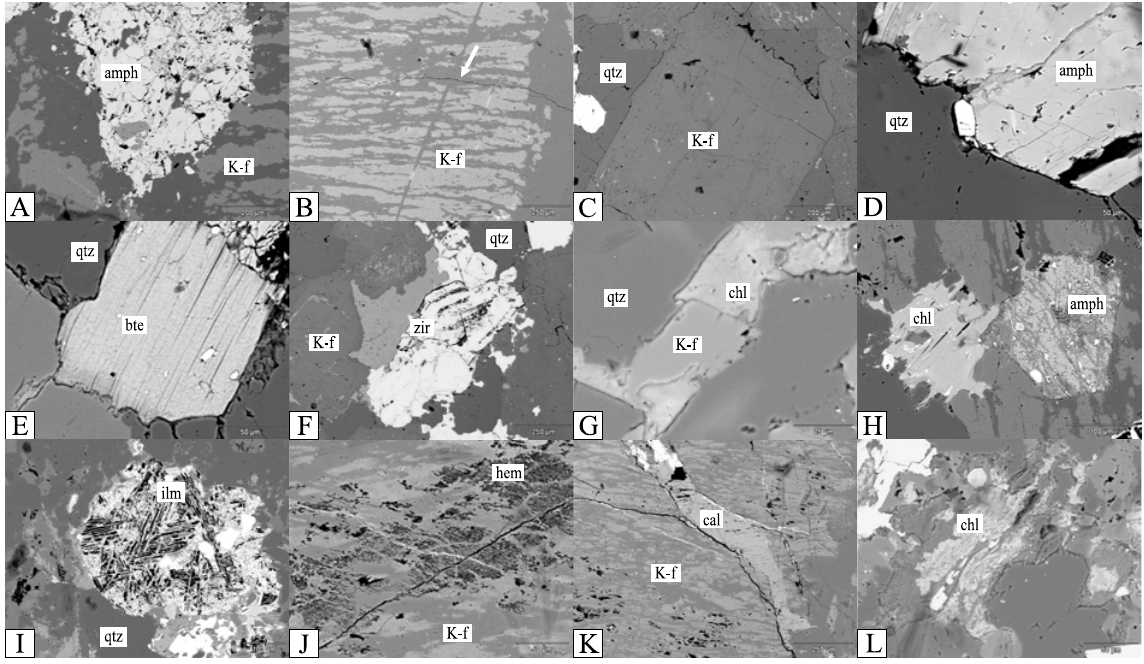
Fig. 3 – SEM images in backscattered mode (A to L) of specific sites indicated by the white letters on autoradiographies (Figure 2, A’ to D’). A – intragranular microfissures in amphibole grain (sample A) that locally coincide with cleavage plans; B – perthitic exsolution texture and twin plans of alkali feldspars (sample A) do not correspond to porous sites. Note transgranular microfissure crosscutting feldspar grain (white arrow); C – fine gained matrix (sample B) yields a narrow and tortuous interconnected network of intergranular microfissures; D and E – intragranular microfissures in mafic minerals (sample B) are associated to cleavage plans of amphibole (D) and biotite (E) and intergranular ones at grain boundaries. Mafic minerals are less fractured and altered in sample B than in sample A; F – dark dots on autoradiography from sample B are associated to zircon and/or monazite crystals; G – highly connected network of tortuous intergranular microfissures from sample C, which is tighter than the same porous zones from sample B due to finer grain size of the matrix; H – pseudomorphic replacement of original biotite and amphibole for chlorite (sample D). Note that open cleavages are wider that on sample B; I – high porous zones (sample C) associated to crystallization of lath-shaped ilmenite particles; J – micro inclusions of hematite on feldspar grains (sample D); K – calcite veinlets and associated microfissures (sample D);